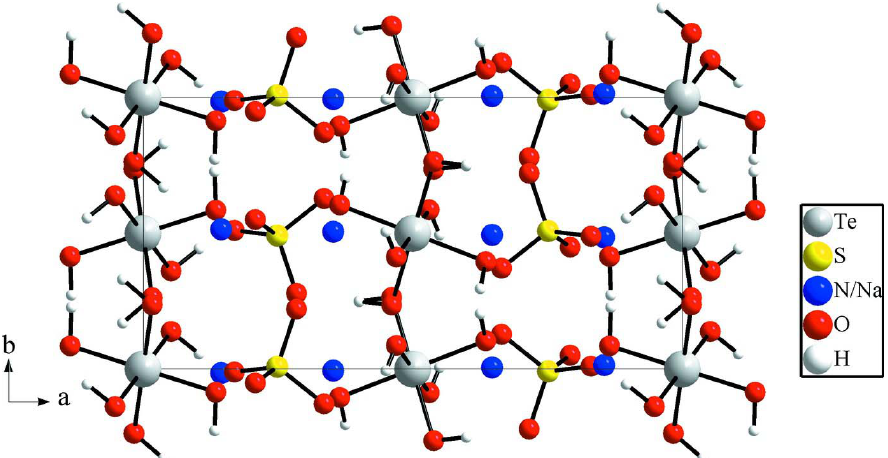
Figure 1 Projection of the crystal structure of the title compound on the ab plane.